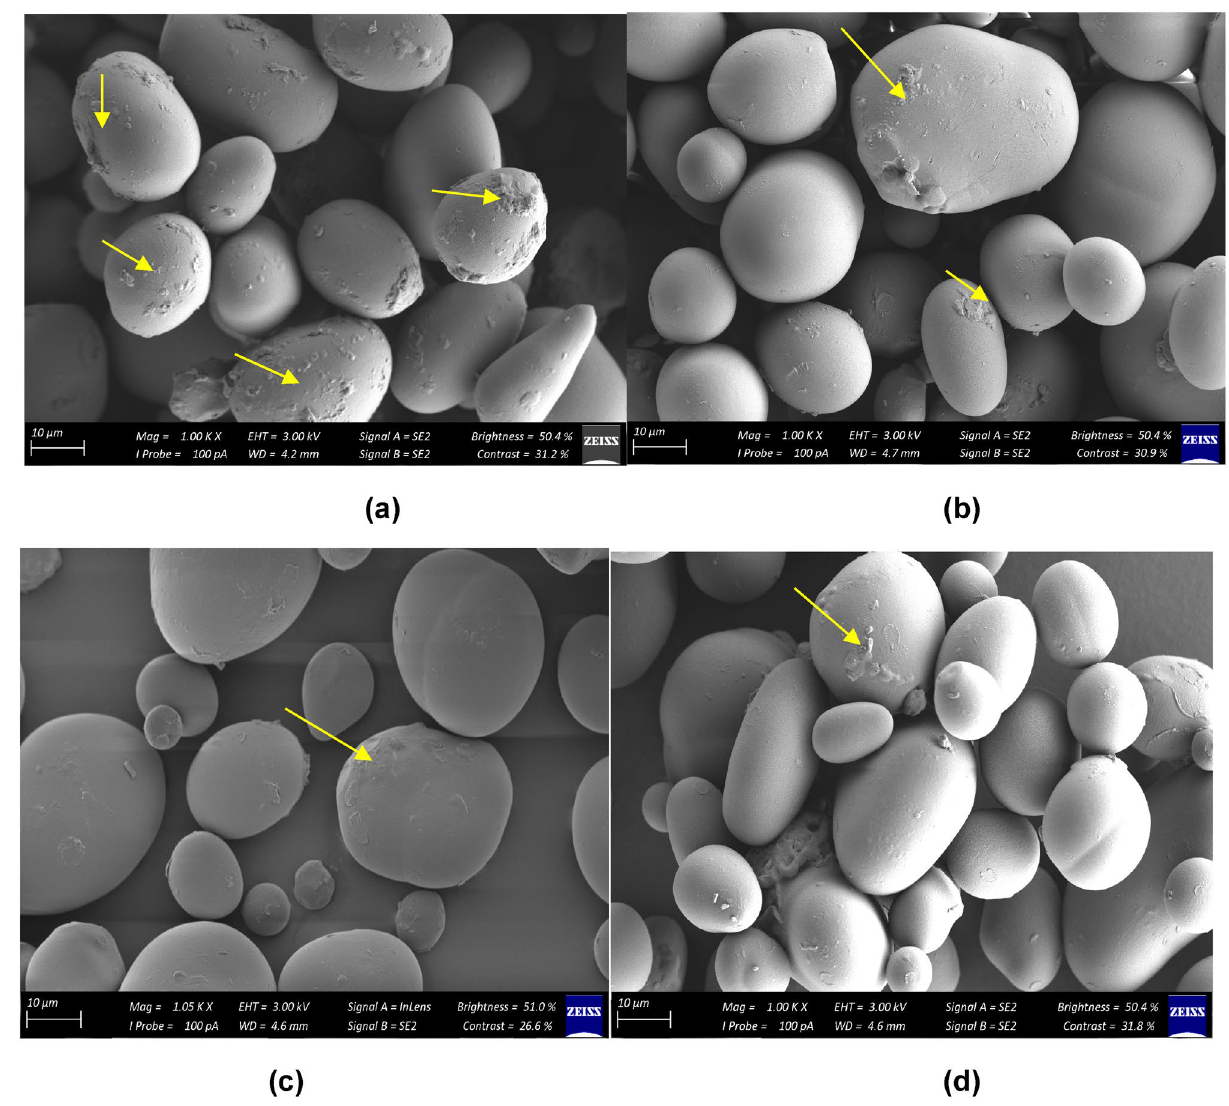
Figure 3. Micrographs of unmodified and heat moisture treated Bambara groundnut starch (BGS). ( a ) Scanning electron micrograph (×100) of unmodified BGS; ( b ) heat moisture treated at 15% moisture content Bambara groundnut starch (HMT 15-BGS); ( c ) HMT 25-BGS; and ( d ) HMT